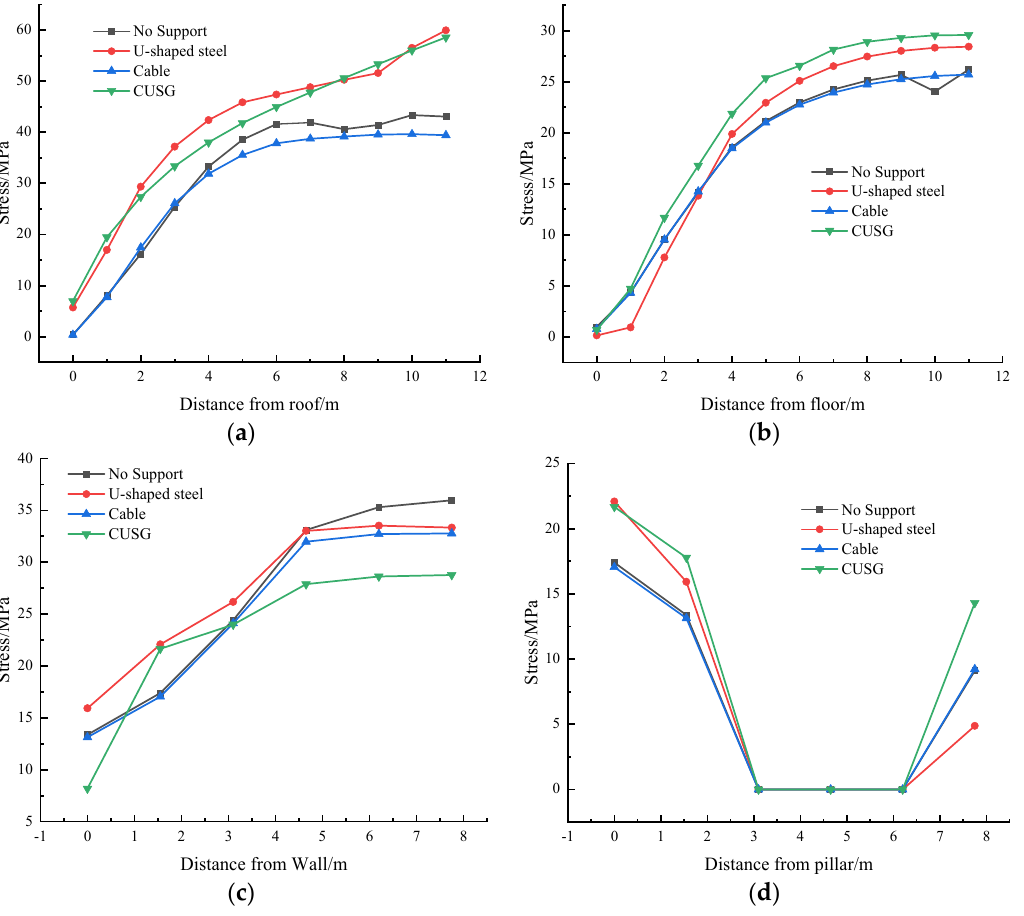
Figure 8. Stress evolution. ( a ) Distance from roof, ( b ) distance from floor, ( c ) distance from wall, and ( d ) distance from pillar.